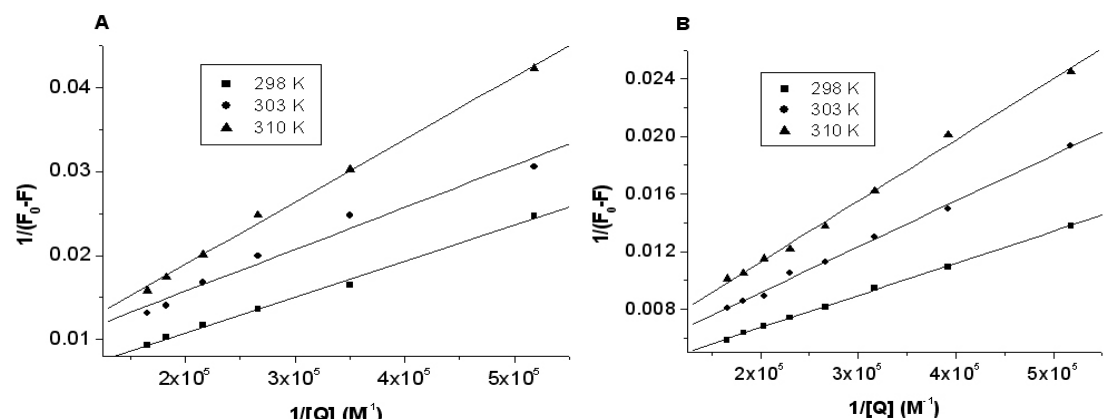
Figure 5. Lineweaver–Burk plots at different temperatures for A) HSA and B) for BSA. Experimental conditions as in Fig. 2.